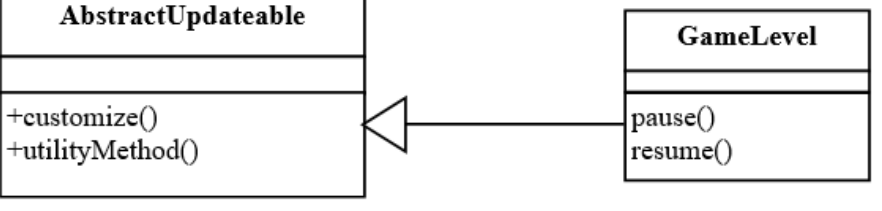
Figure 15. Similar Levels pattern.